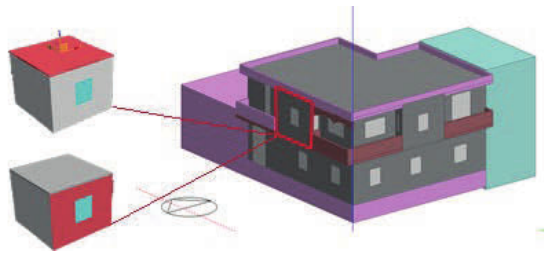
Fig. 2. The Simulation Model Extracted Room Design